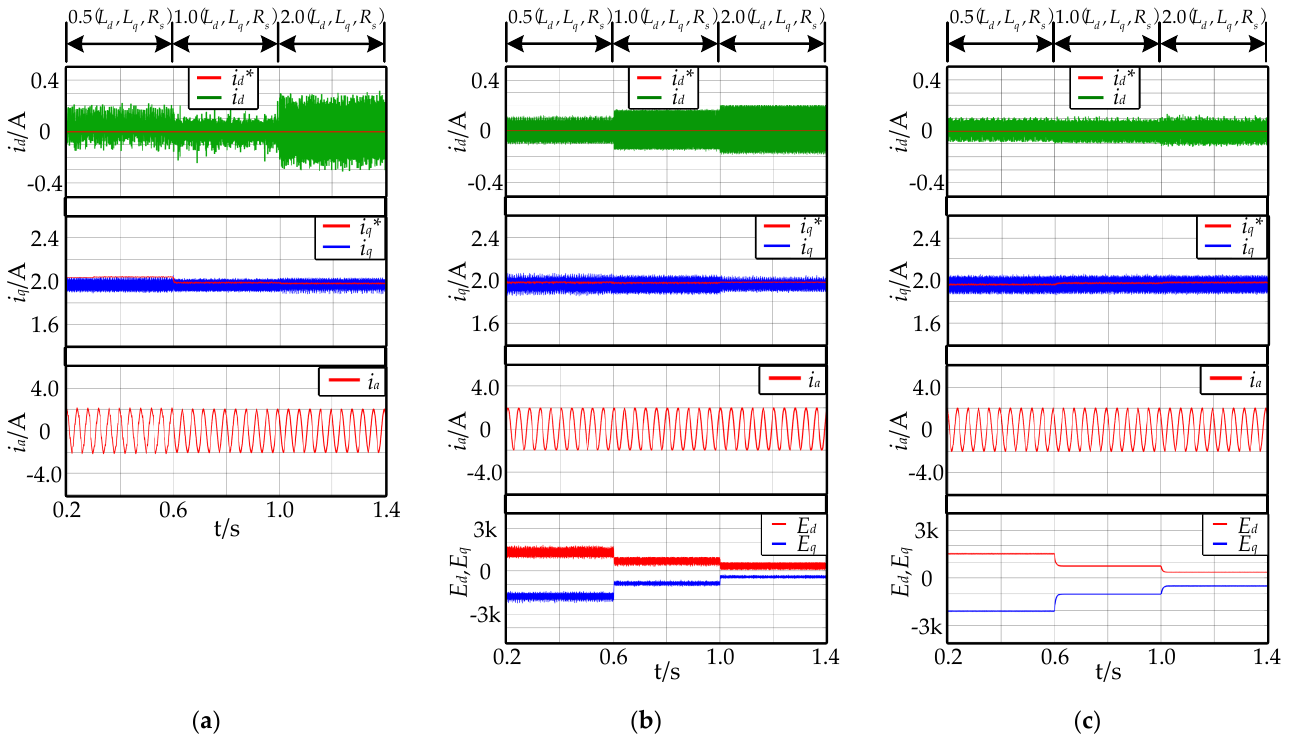
Figure 3. Simulation results of dq − axis current , phase current and dq − axis total disturbance under the change of motor parameters: ( a ) MPCC; ( b ) CMFPCC; ( c ) IMFPCC.